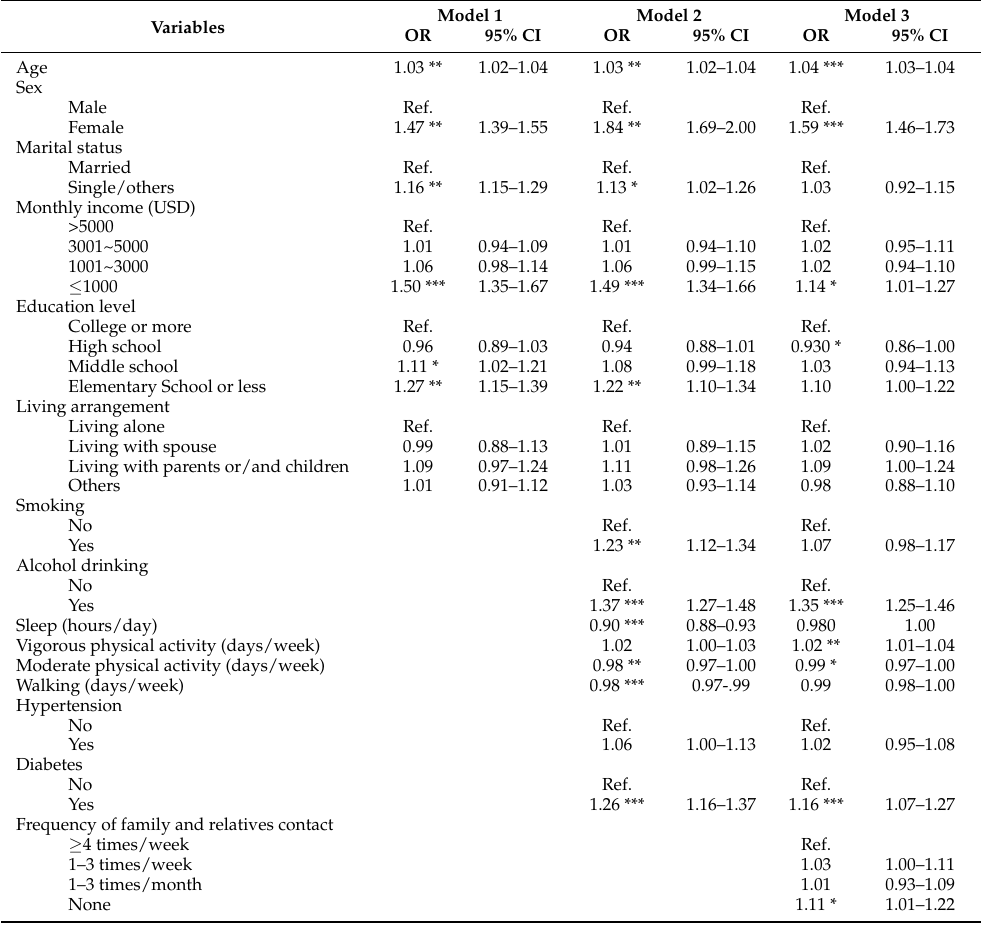
Table 3. Factors influencing subjective cognitive impairment among middle-aged